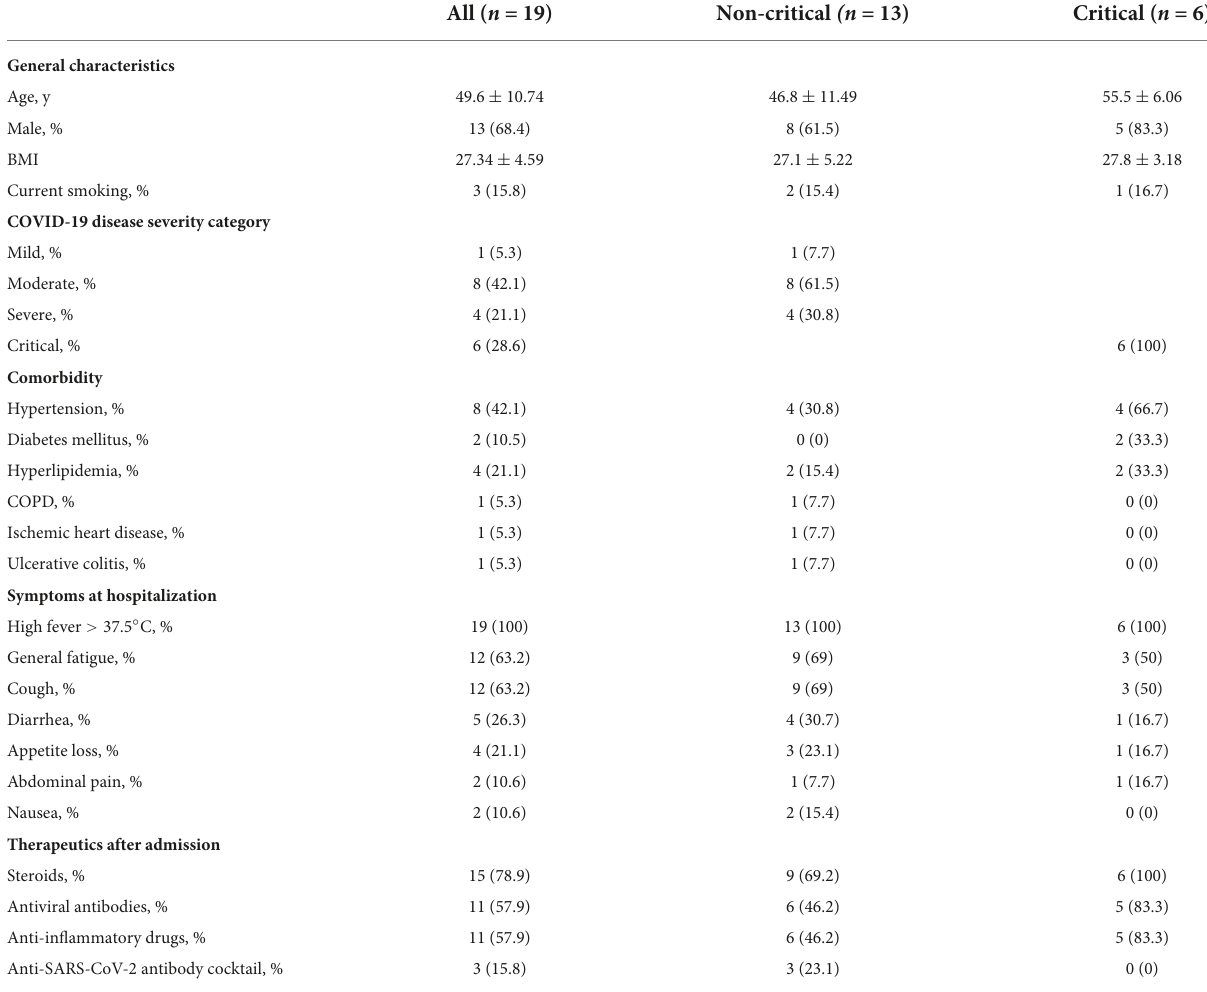
TABLE 1 Clinical characteristics of the COVID-19 patients included in the